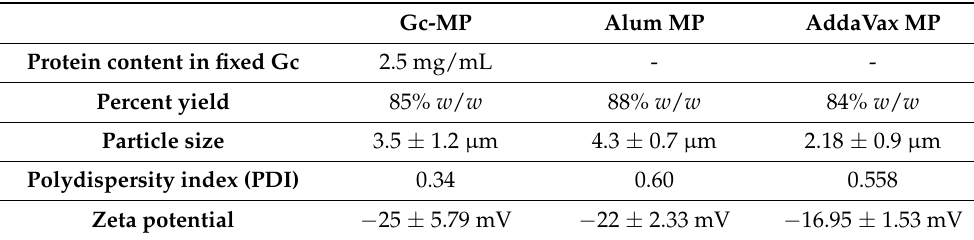
Table 1. Characterization of gonococci vaccine and adjuvant microparticles. Gc-MP Alum MP AddaVax MP Protein content in fixed